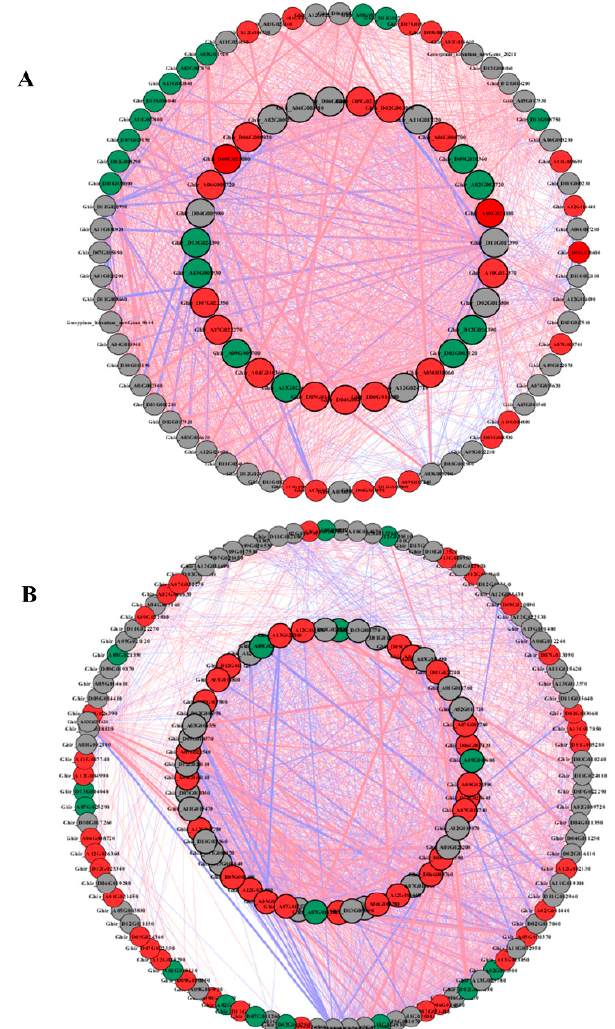
Figure 6. The Pearson correlation network reveals the regulatory mechanisms of amino acid, carbon, and nitrogen metabolism. ( A ) Coexpression network of genes in roots; ( B ) coexpression network of genes in shoots. Different colors of nodes represent amino acid (red), carbon (gray), and nitrogen (green). Red edges represent positive correlations and blue edges represent negative correlations. The thickness of each edge represents the value of the correlation coefficient for each correlated pair. Hub genes are highlighted with thick and black edging. The coexpression networks were made with p > 0.95 as the threshold.